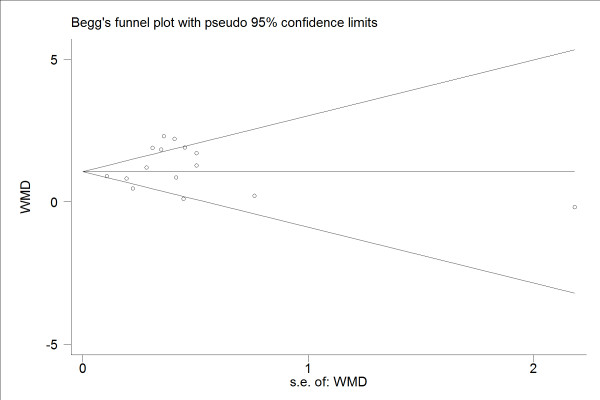
Begg's funnel Plot.